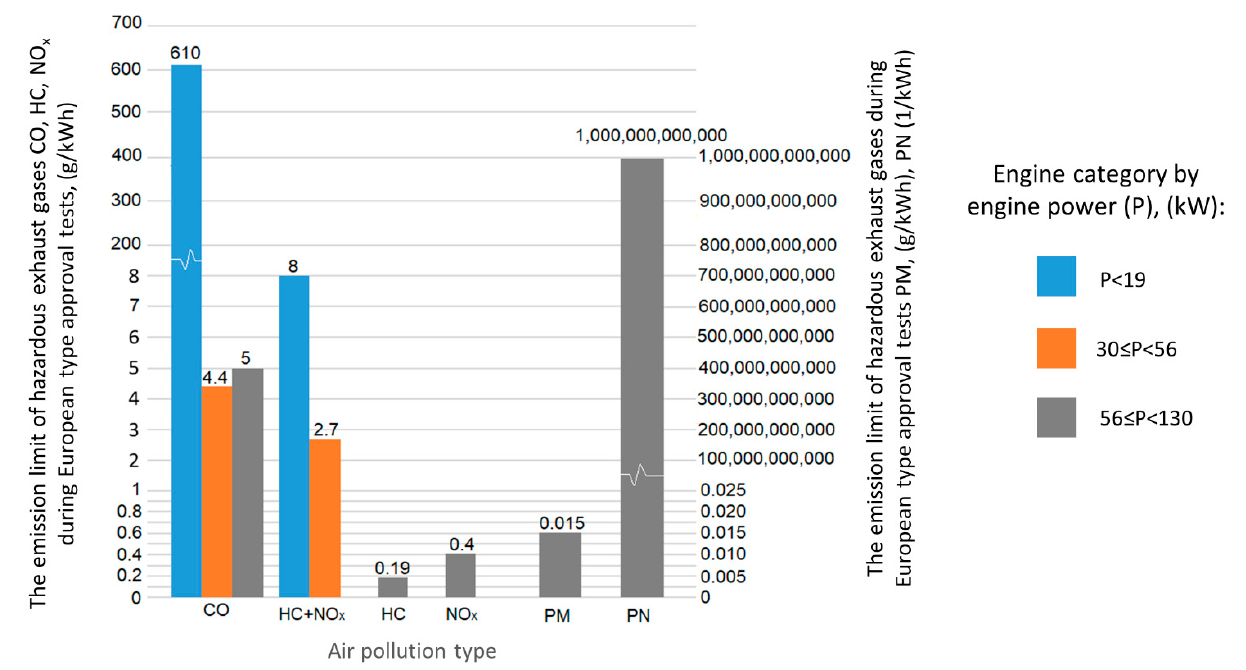
Figure 3. Limits of air pollution generated by internal combustion engines of fans, depending on the power-related engine